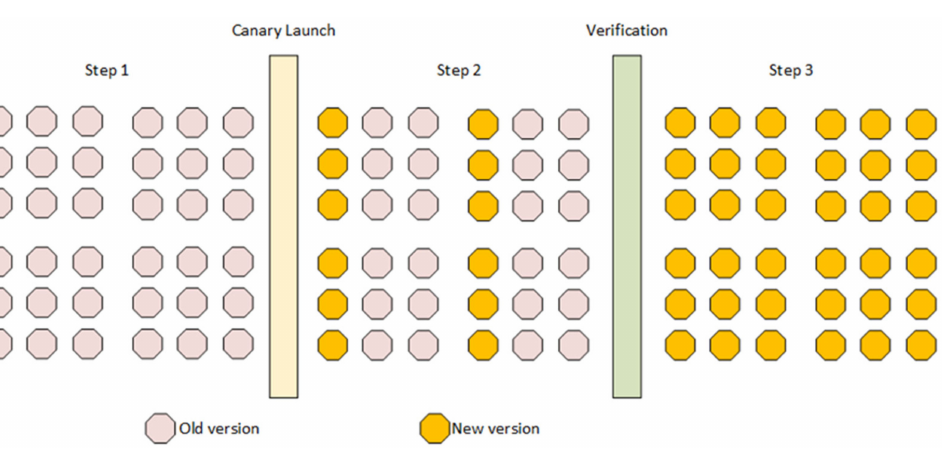
Figure 2. Canary deployment